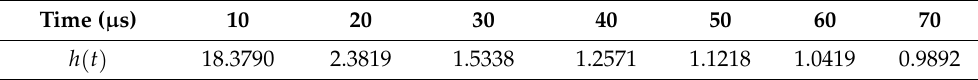
Table 2. Theoretical calculation results of peak-to-peak ratio at different zero-crossing points. Time ( µ